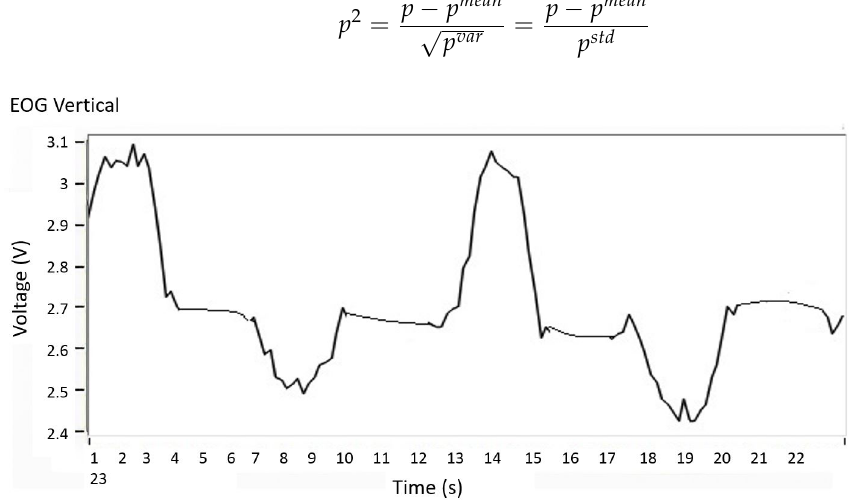
Figure 14. Filtered EOG signal. EOG signal free of induced noise. To perform the identification of patterns in the EOG signal through two channels, they are divided into negative action potentials (left/down), positive action potentials (right/up) and inactivity potentials (blinking and involuntary movements when looking straight ahead). Each of these classes of the EOG signal is labeled by an integer. This type of encoding is appropriate if there is an order relationship between the categories; this type of data is known as ordinal. Figure 15 shows the waveform of each of the EOG channels and the eye movement it represents; also, the detection of blinking in both EOG channels (horizontal/vertical) is added to the training dataset in order to prevent involuntary movements being recognized as control